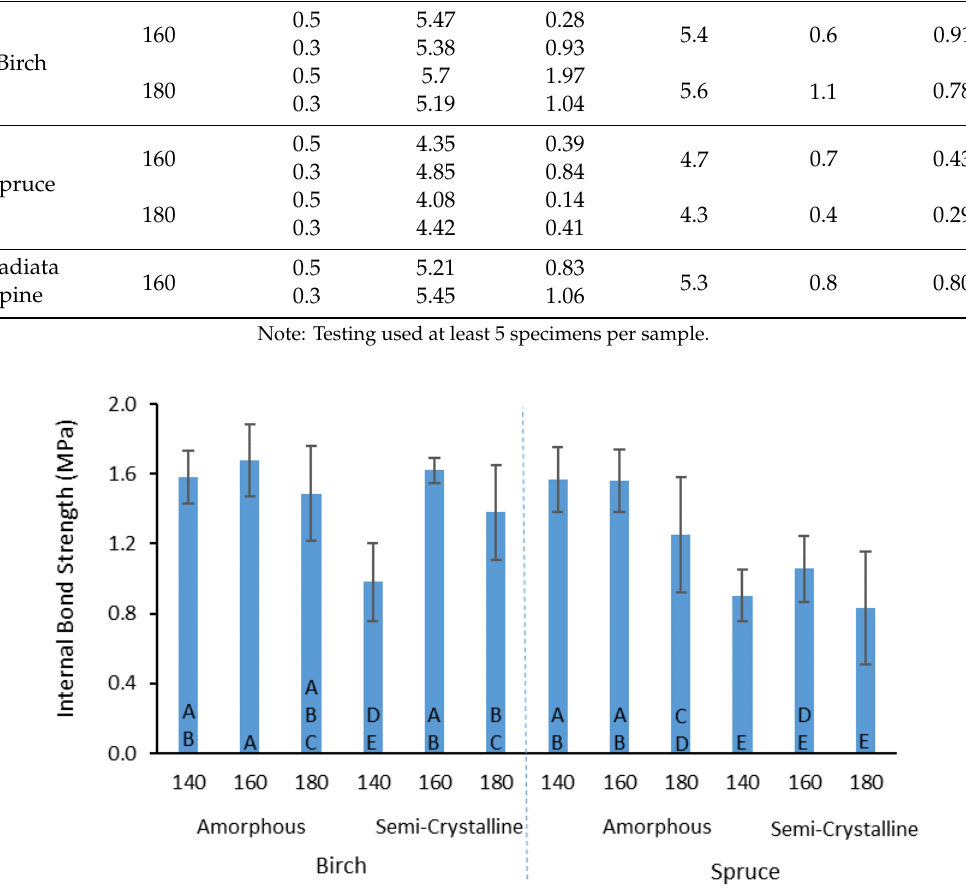
Figure 4. Comparison of internal bond testing results for laminated panel samples, including grouping of results. Levels not connected by the same letter are significantly di ff